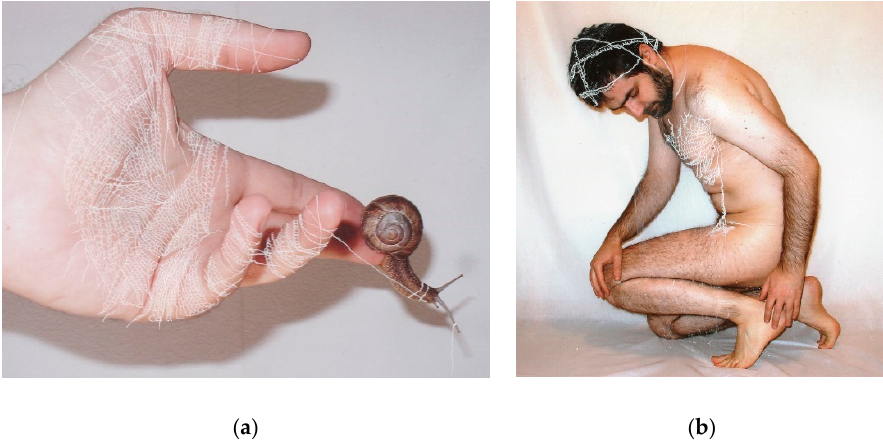
Figure 2. Peter Tzanev, Ectoplastic exercises: ( a ) Non-sensitive drawings (Snail), 2007; ( b ) Ectoplastic drawing, 2007; Images created by author.